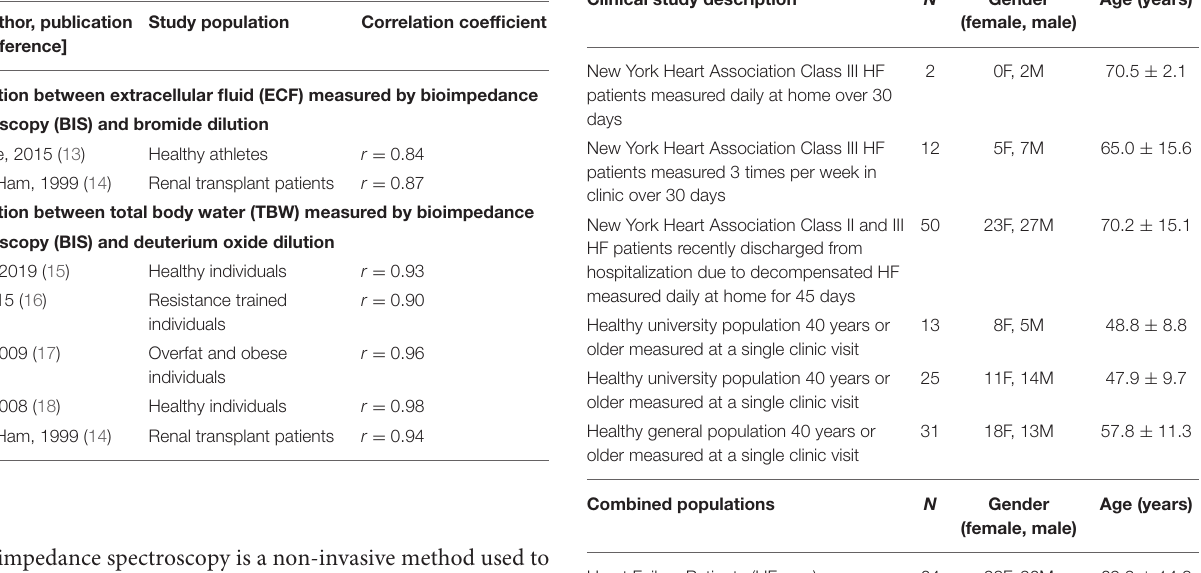
TABLE 1 | ECF and TBW correlation coefficients for BIS measurements vs. gold-standard dilution techniques.